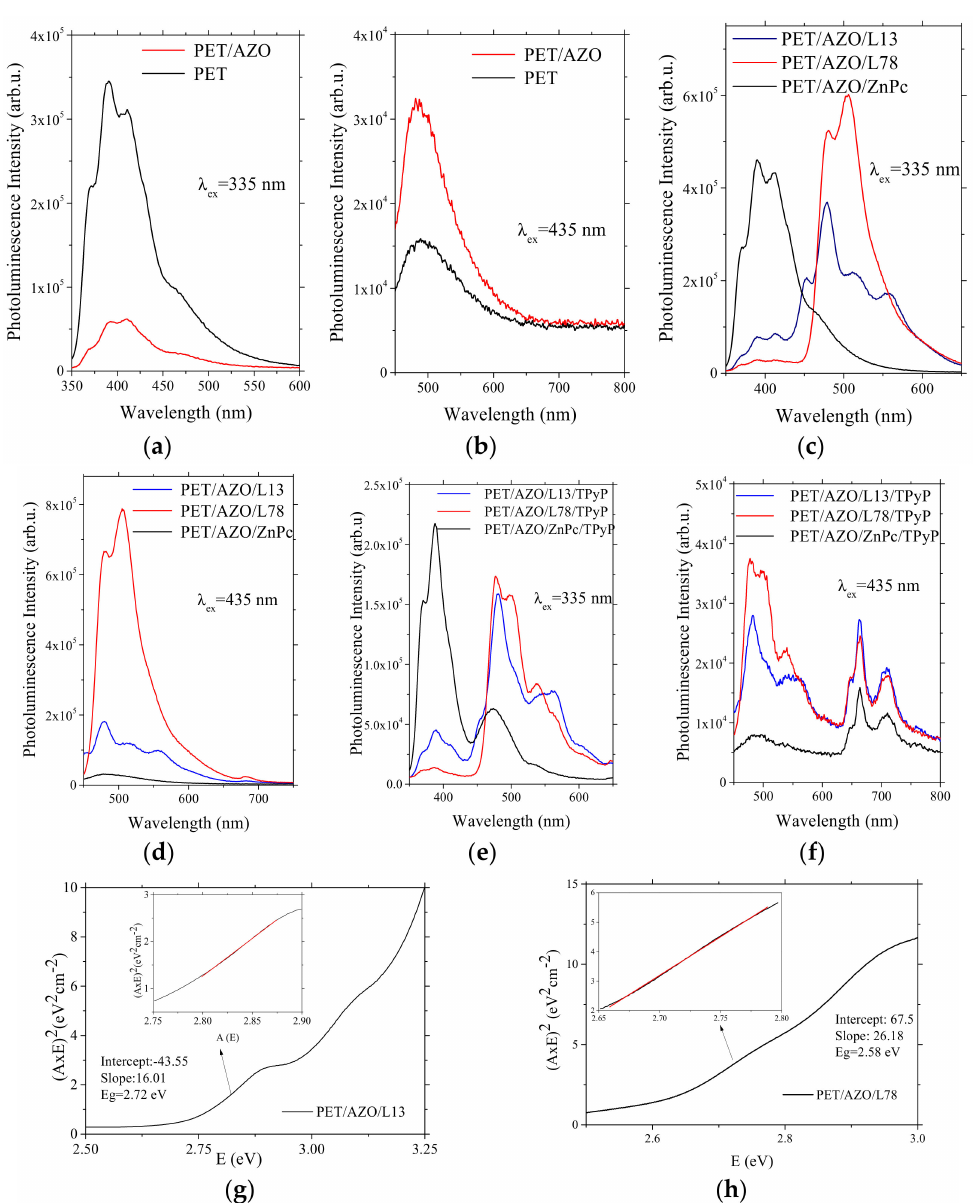
Figure 8. PL spectra of AZO layer deposited on PET substrate, λ excitare = 335 nm ( a ). AZO layer deposited on PET substrate, λ excitare = 435 nm ( b ). Single-layer organic on PET/AZO, λ excitare = 335 nm ( c ). Single-layer organic on PET/AZO, λ λ λ excitare = 435 nm ( d ). Bi-layer organic on PET/AZO, excitare = 335 nm ( e ). Bi-layer organic on PET/AZO, excitare = 435 nm ( f ). Tauc plot for L13 deposited on PET/AZO ( g ). L78 film deposited on PET/AZO ( h ), where A is absorbance and E is the photon energy. The substrates for ( c – f ) samples are indicated in Table